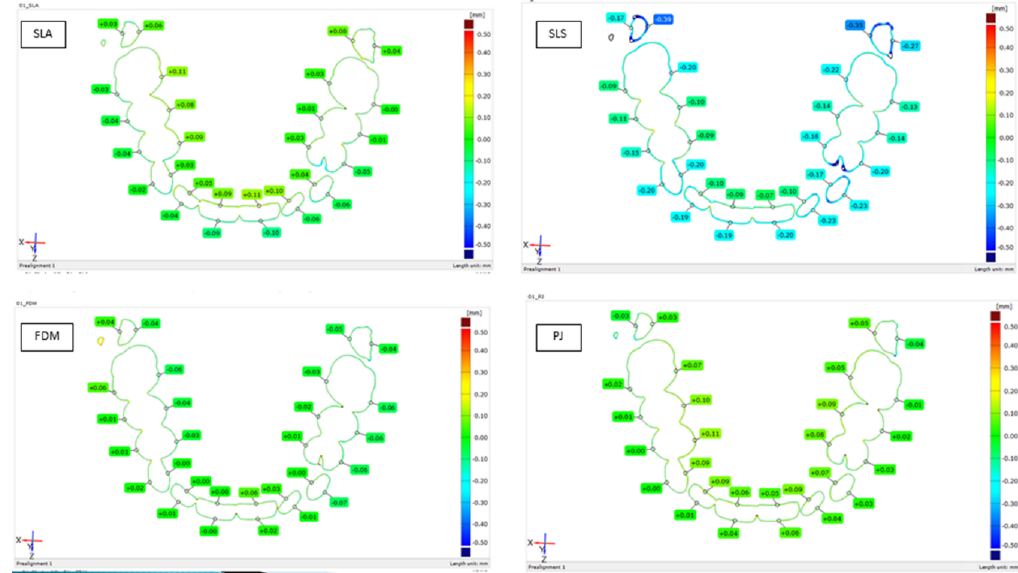
Figure 2. Precision of models in cross-section among 3D printers: stereolithography ( SLA ), selective laser sintering ( SLS ), fused-deposition modeling ( FDM ) and polyjet technology ( PJ